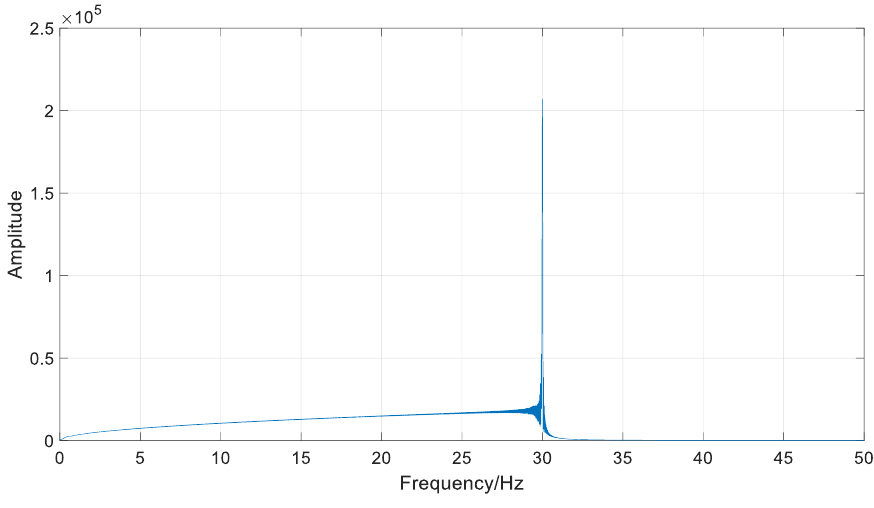
Figure 6. The frequency-domain result of the simulated signal.